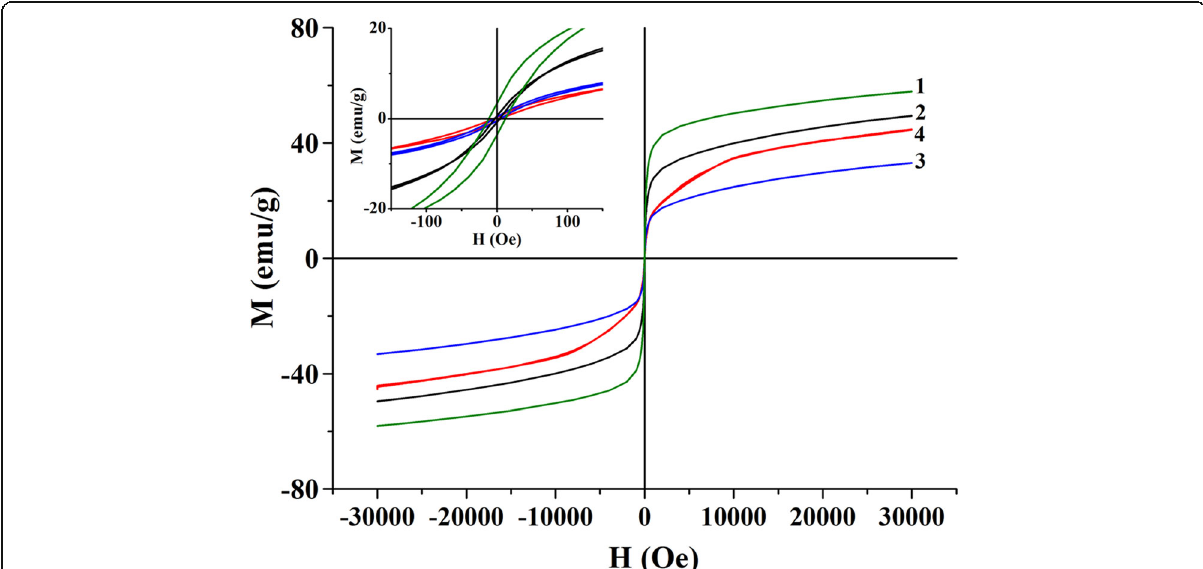
Fig. 3 Field dependences of magnetization for LSMO nanoparticles synthesized via sol-gel method (1), by precipitation from DEG solution (2), and by precipitation from reversal microemulsions based on Triton X-100 (3) and CTAB (4). Dependences of magnetization in the weak fields are shown in the inset